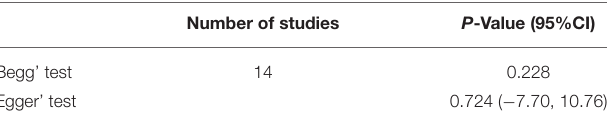
TABLE 3 | Results of meta-regression